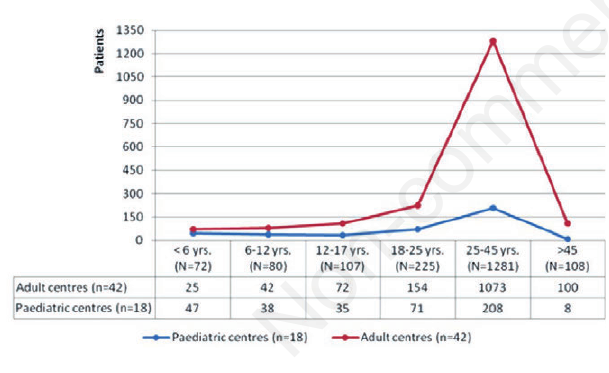
Figure 1. Patients’ distribution in paediatric/no paediatric centres.